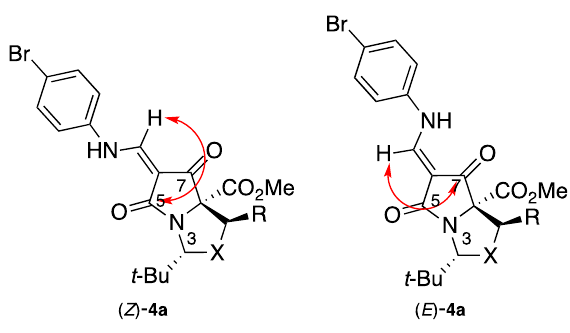
Figure 1. NMR characterization of key compounds.